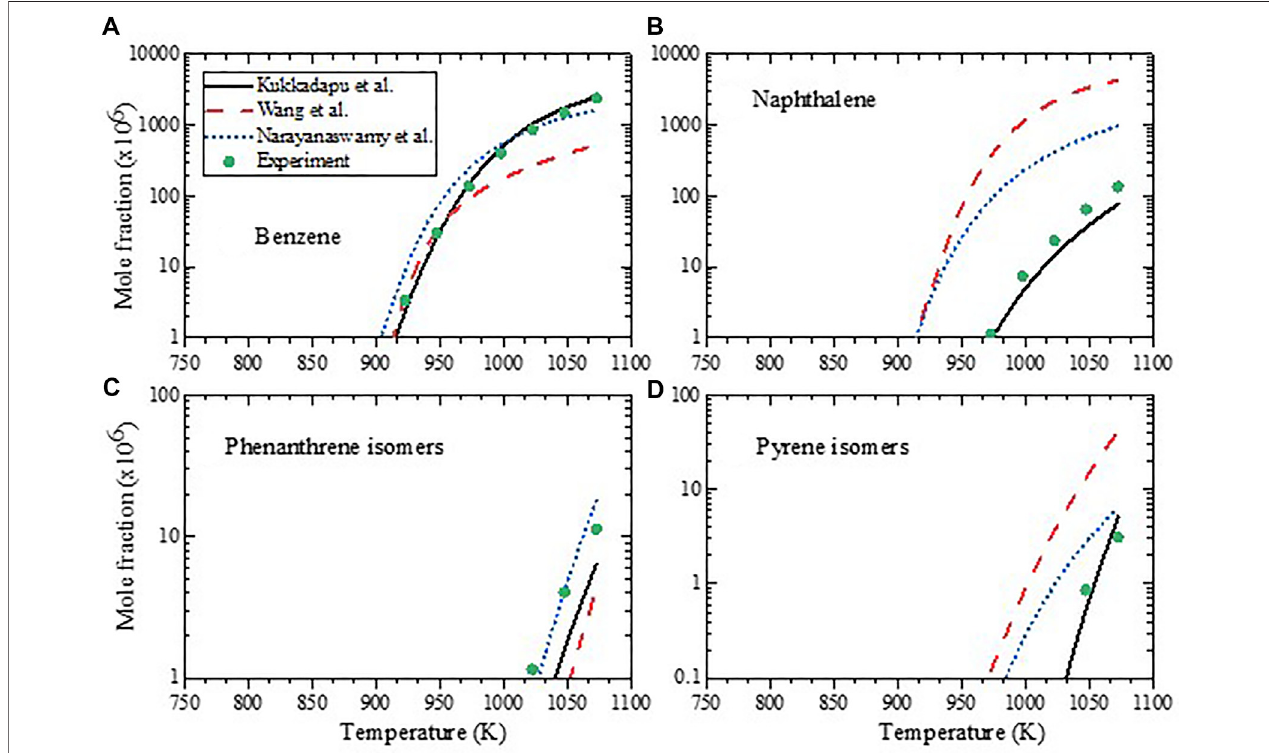
FIGURE2| Plotsshowingtheperformanceofthedifferentmechanismsincapturingtheformationof (A) benzene, (B) naphthalene, (C) phenanthreneisomers,and (D) pyrene Isomers during pyrolysis of n-dodecane in a JSR. Experimental data are from Herbinet et al. (2007).